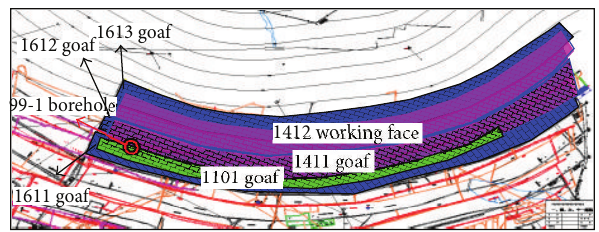
Figure 9: Synthetic plan view of the 1412 fully-mechanized top-coal caving face.